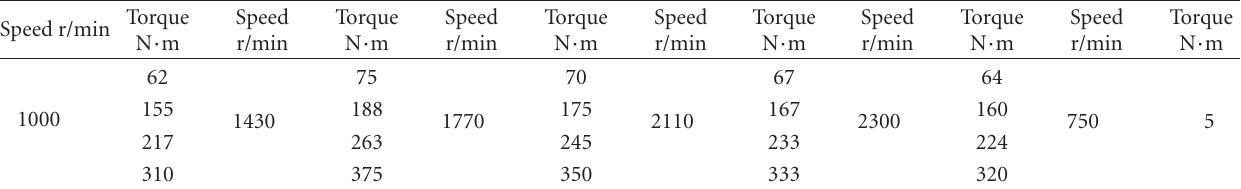
Figure 12: NO x and soot emissions comparison between premixed combustion and original engine combustion. Table 8: Test operating conditions for premixed